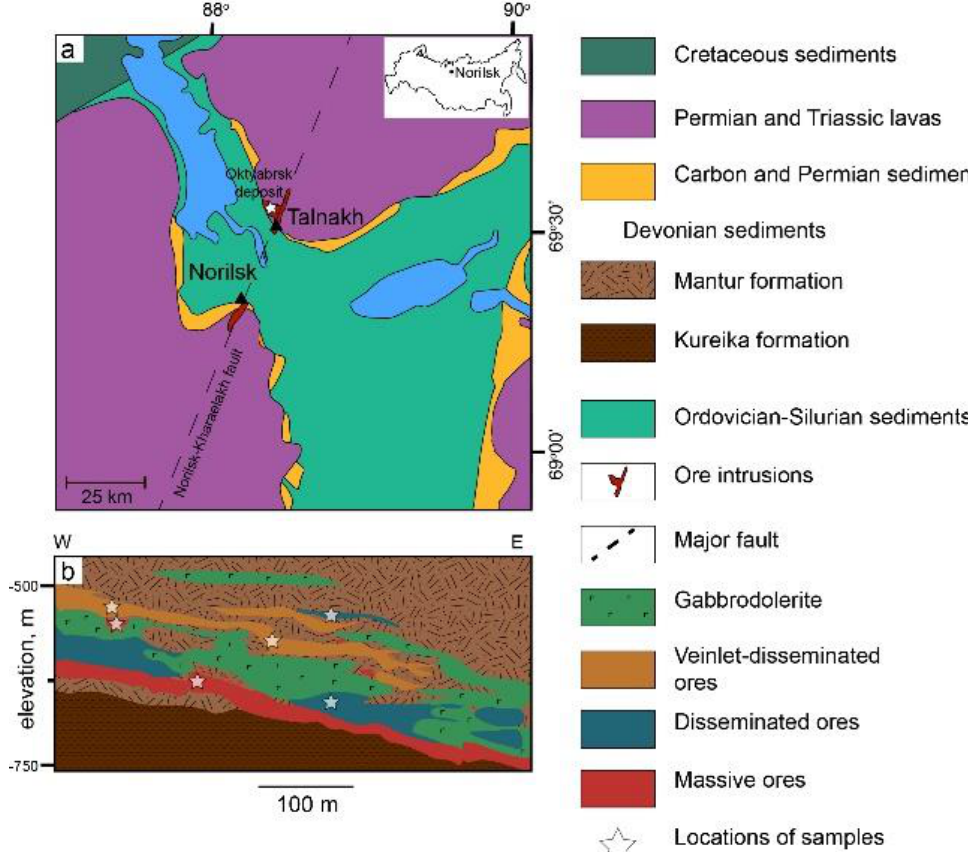
Figure 1. A schematic geologic map of the studied region ( a ) and a geologic cross-section of the Oktyabrsk deposit hosted by the Kharaelakh intrusion and its metamorphic aureole ( b ) based on [48]. Gabbrodolerites of the Kharaelakh intrusion were dated by CA-ID-TIMS on zircon to 251.71 ± 0.31 Ma (2 σ external error including 238 U decay constant) [27]. Coeval, though with much large uncertainty, dates were obtained by U-Pb LA-ICPMS on metamorphic minerals of the veinlet-disseminated ores [49].